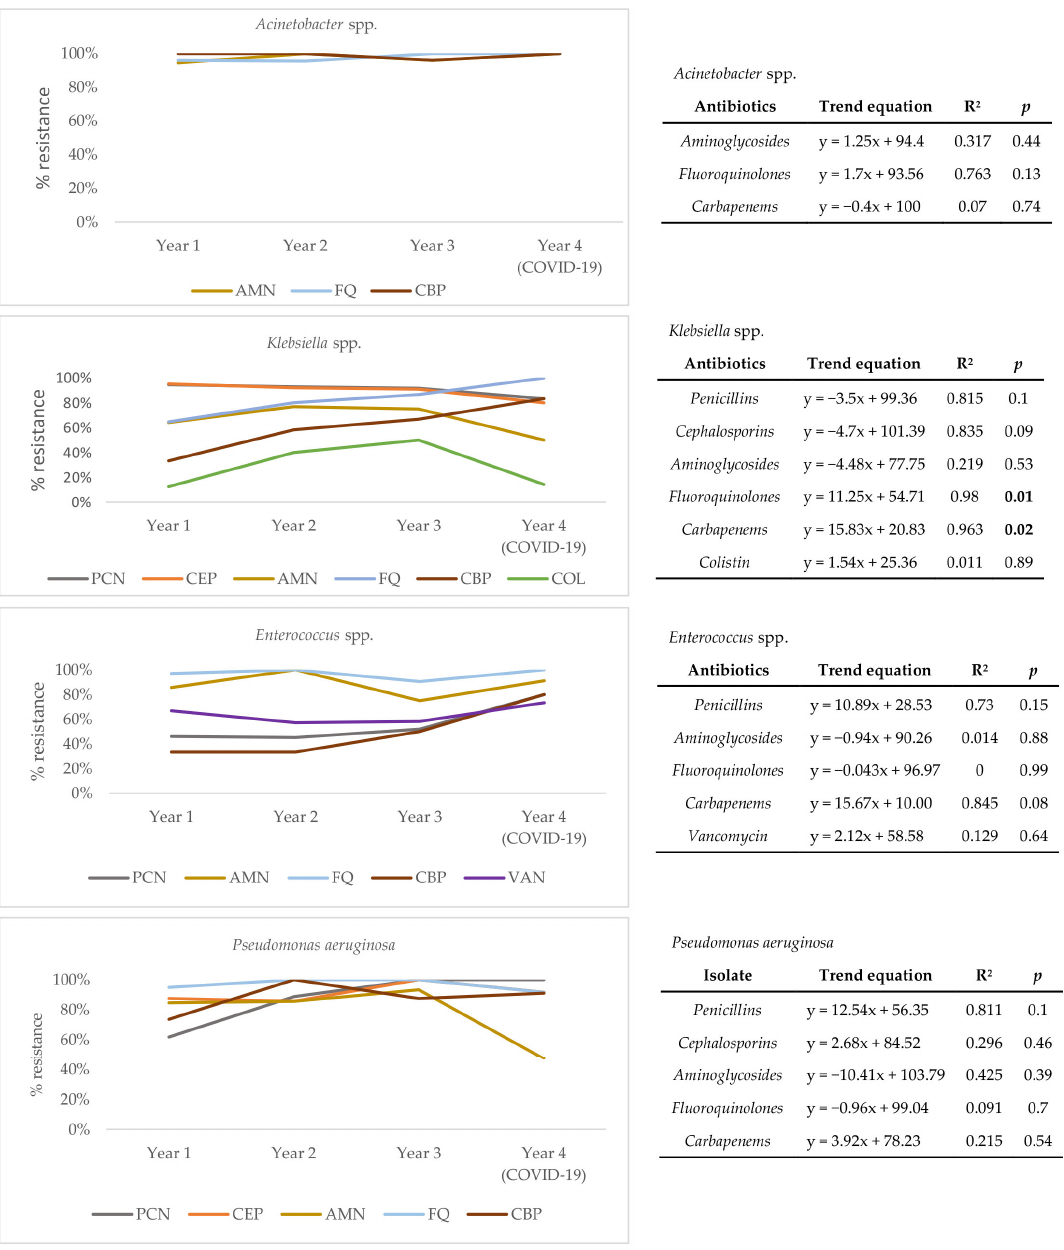
Figure 3. Trends of antimicrobial resistance for Acinetobacter spp., Klebsiella spp., Enterococcus spp., and Pseudomonas aeruginosa isolated over four years of follow-up. AMN, aminoglycosides; FQ, fluoroquinolones; CBP, carbapenems; PCN, penicillins; COL, colistin; VAN, vancomycin; R 2 —coefficient of determination; statistically significant values ( p < 0.05) marked in